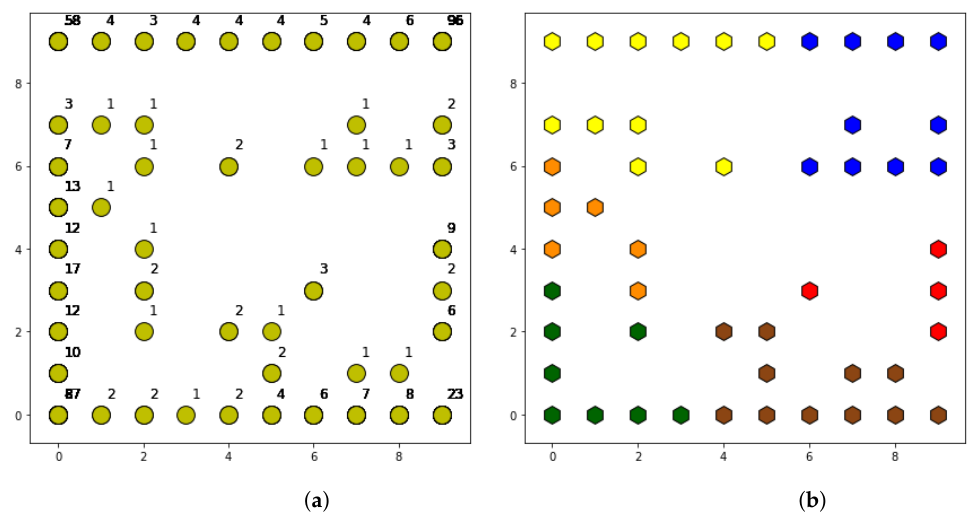
Figure 5. ( a ) Map of neurons at SOM output. ( b ) Map of neurons at post-processing output. This set of patterns is analyzed in detail by comparing the KPIs of the cells associated with each behavior pattern. In Table 6, patterns found in the commercial network are characterized with the shown statistics. Table 6. Patterns and statistics per